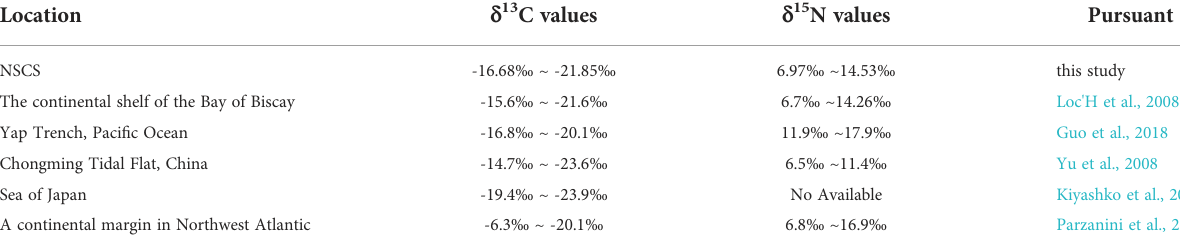
TABLE 2 d 13 C and d 15 N values of benthic organisms in different locations.